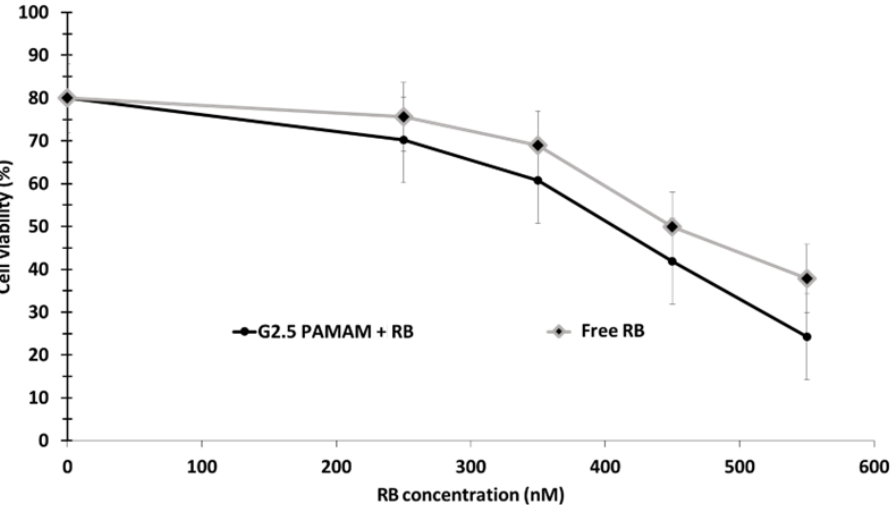
Figure 28. DLA cell viability following incubation with G2.5 PAMAM + RB and free RB upon exposure to a 150 W xenon lamp (540 nm, 10 min). Adapted from Karthikeyan et al. [69].